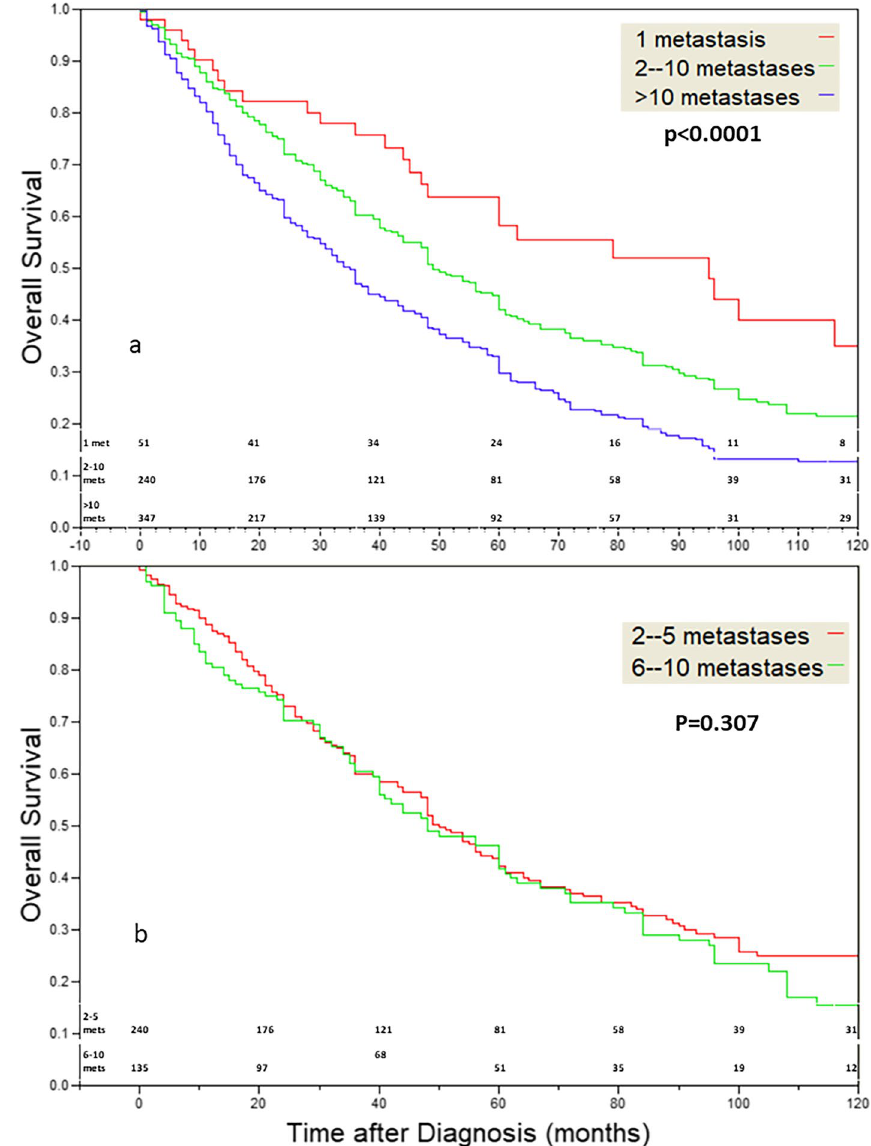
Fig. 1 a The effect of metas- tases number on OS. The cutoffs used are: 1, 2–10, > 10 metastases (p < 0.0001). b The effect of metastases number on OS. Cutoffs at 2–5 and at 6–10 show an almost identical decay. (p =